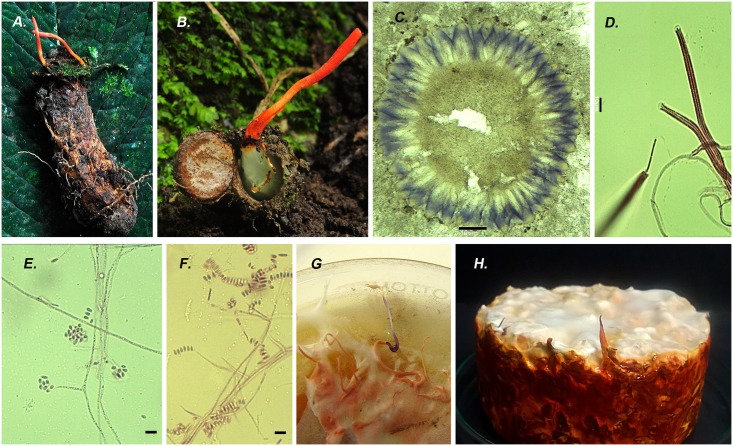
Cordyceps nidus.A) Stromata emerging from a nest of trapdoor spider from the family Idiopidae ANDES-F 1080 B) Inside of the nest with the red stromata on the lid HUA 186125. C) Cross-section of perithecia turned purple with KOH. D) Asci and ascospores stained with fucsin acid dye. E-G) Conidial state of C. nidus E) Long and slender phialides with a conidial head produces on prostate narrow hypha. F) Conidia in a row showing different shapes and sizes. G) Synnemata isolated in PDA turned purple on the tip due to the reaction with KOH 3%. H) Synnemata Isolated on brown rice showed strong red pigments after 30 days. Scale bars: C = 100 μm 10 ×, D-F = 10 μm 100 ×.